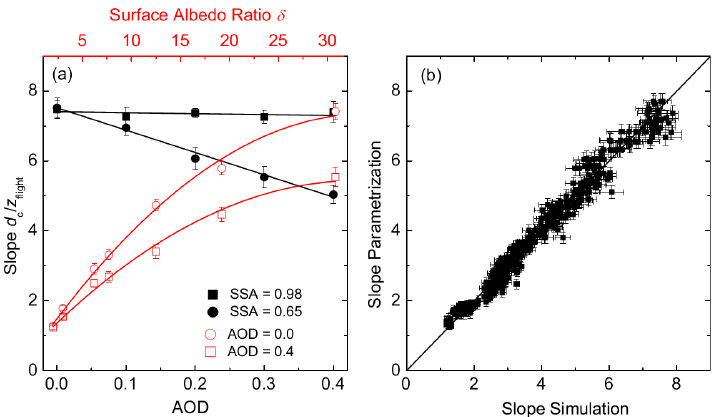
Fig. 3. (a) Slope d c /z flight as a function of aerosol optical depth ( θ 0 =30 ◦ , δ =30.8, g =0.75, ˜ ω =0.65 and 0.98), and surface albedo ratio δ = ρ land / ρ sea ( θ 0 =30 ◦ , ˜ ω =0.75, g =0.65, AOD=0.0 and 0.4). (b) Relationship of the slopes derived from the radiative transfer simulation and the parameterized slopes. Additionally, the one-to-one line is plotted.